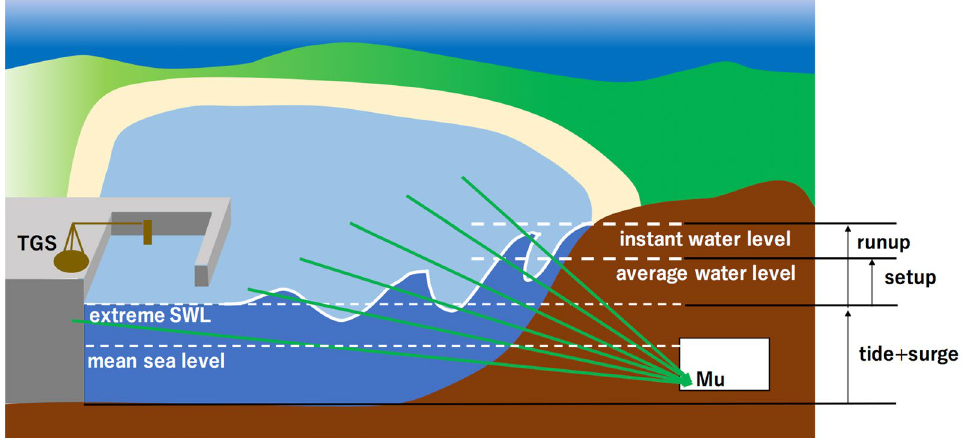
Figure 1. Conceptual view of muography for tide monitoring. The label TGS stands for a tide gauge station, and Mu indicates the location of a muograph (muographic observation and recording device). Green arrows indicate muon trajectories. HKMT drew this image with Microsoft PowerPoint software and holds the